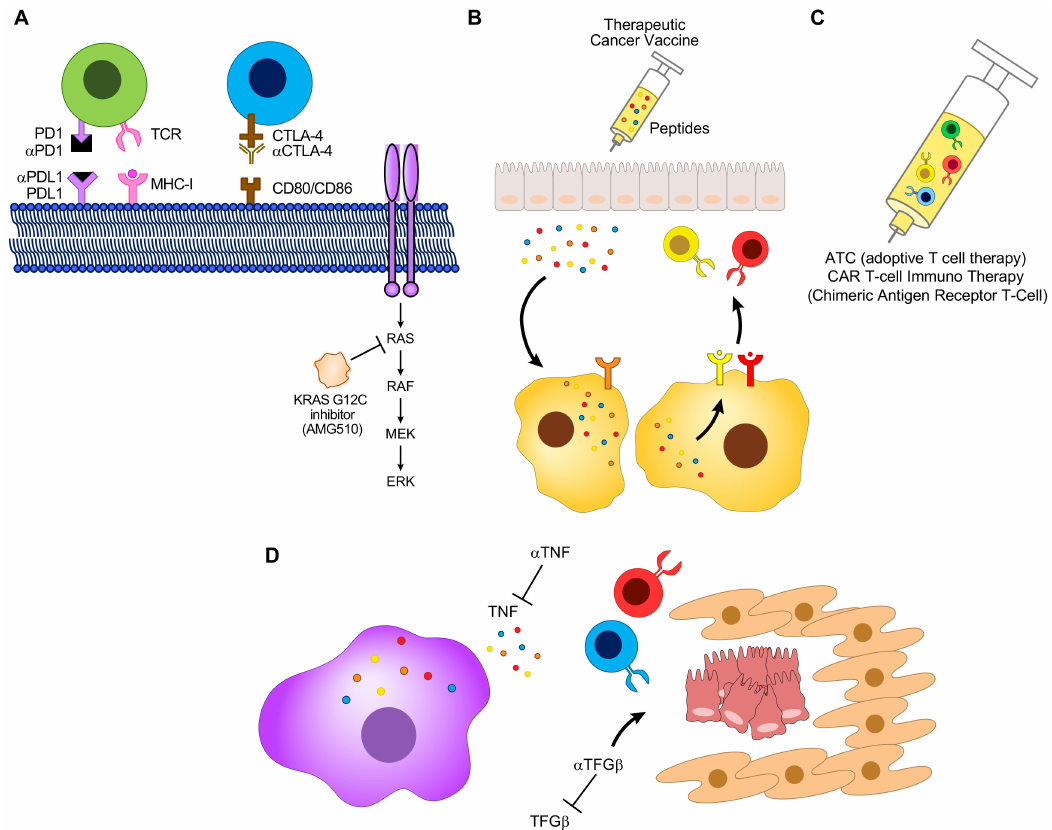
Figure 3. The future of CRC therapy: combinatorial agents. The current status of the use of inhibitor therapy (ICI) in the treatment of CRC has shown promising results, despite the lack of a complete response in dMMR-MSI-H tumors, and no response in pMMR-MSI-L. This obstacle has paved the way for insight and research into plausible combinatorial agents that can overcome this scientific impediment. ( A ) ICI in combination with AMG 510, a KRAS (G12C) inhibitor, or ( B ) therapeutic cancer vaccines, or ( C ) adoptive T cell therapy, or ( D ) TNF and TGF β inhibitors may serve as the next candidates for combinatorial therapy with